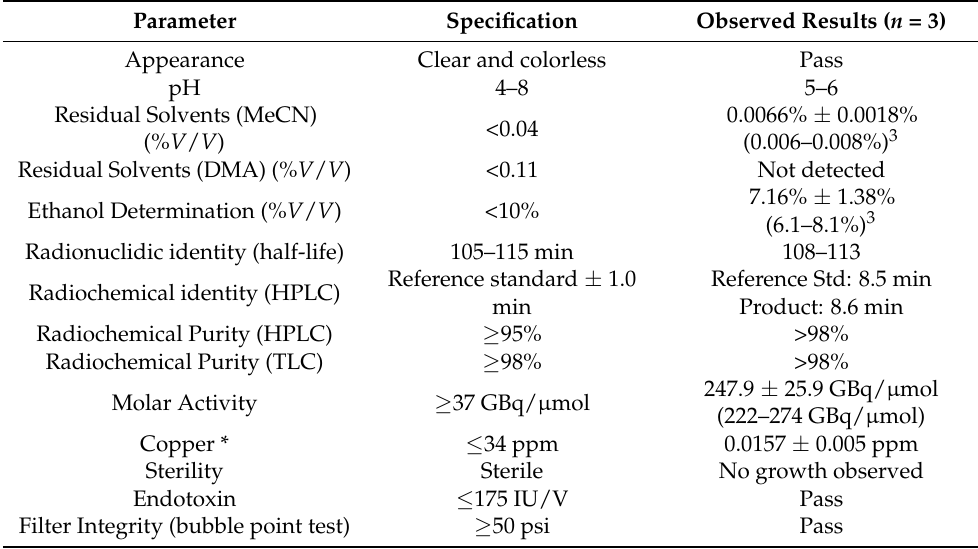
Table 3. Quality control specifications of [ 18 F]FMZ 1 .